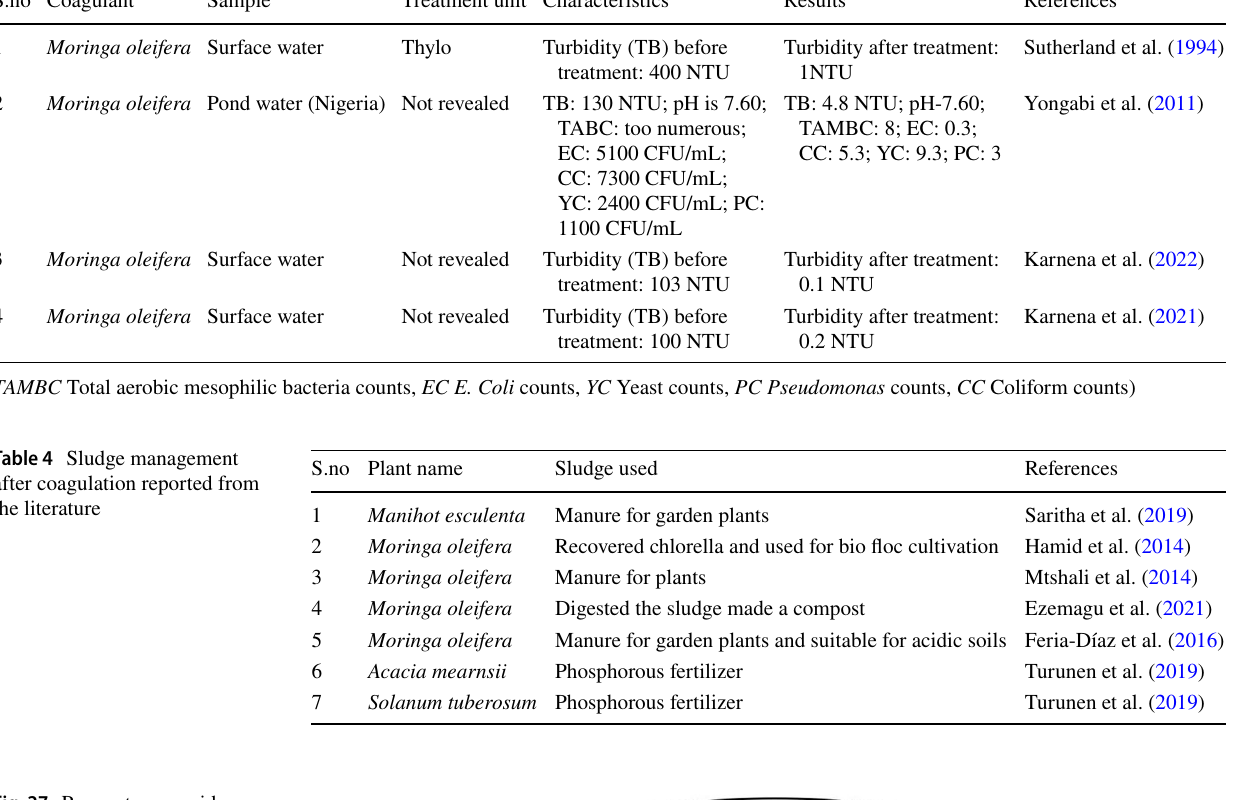
Fig. 27 Parameters consid- ered for the sustainability of plant-based coagulants in water